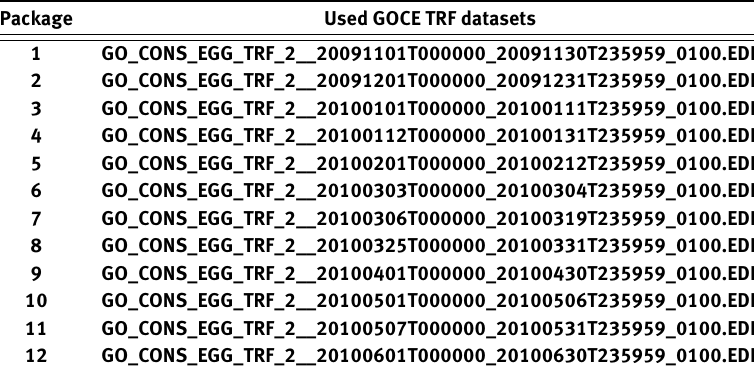
Table 1. GOCE TRF gradient data packages and related time interval covered.